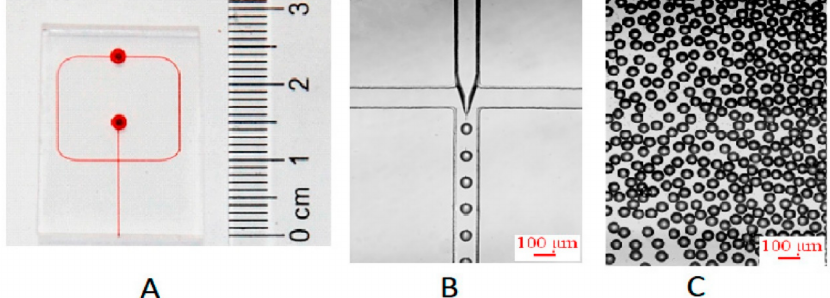
Figure 7. ( A ) Photograph of the polydimethylsiloxane (PDMS) microchip. Channel and reservoirs were full of red ink for visualization. ( B ) Micro photo of the process of microdroplets preparation at cross-junction channel. The velocity of the aqueous phase and oil phase was 14 and 80 µ L/min, respectively. ( C ) Microphoto of microdroplets off-chip. Reprinted from an open-access source [54].